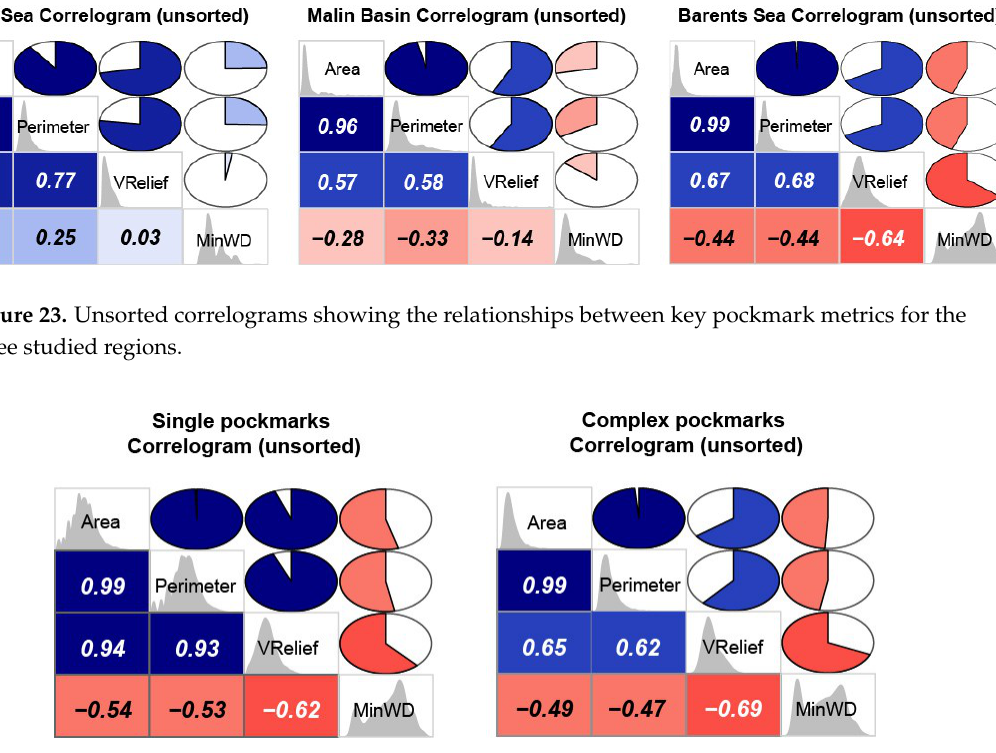
Figure 24. Unsorted correlograms showing the different relationships between key pockmark metrics for the two types of pockmarks found in the Barents Sea. Note the higher value of correlation between Area and Vertical Relief for the single pockmarks.